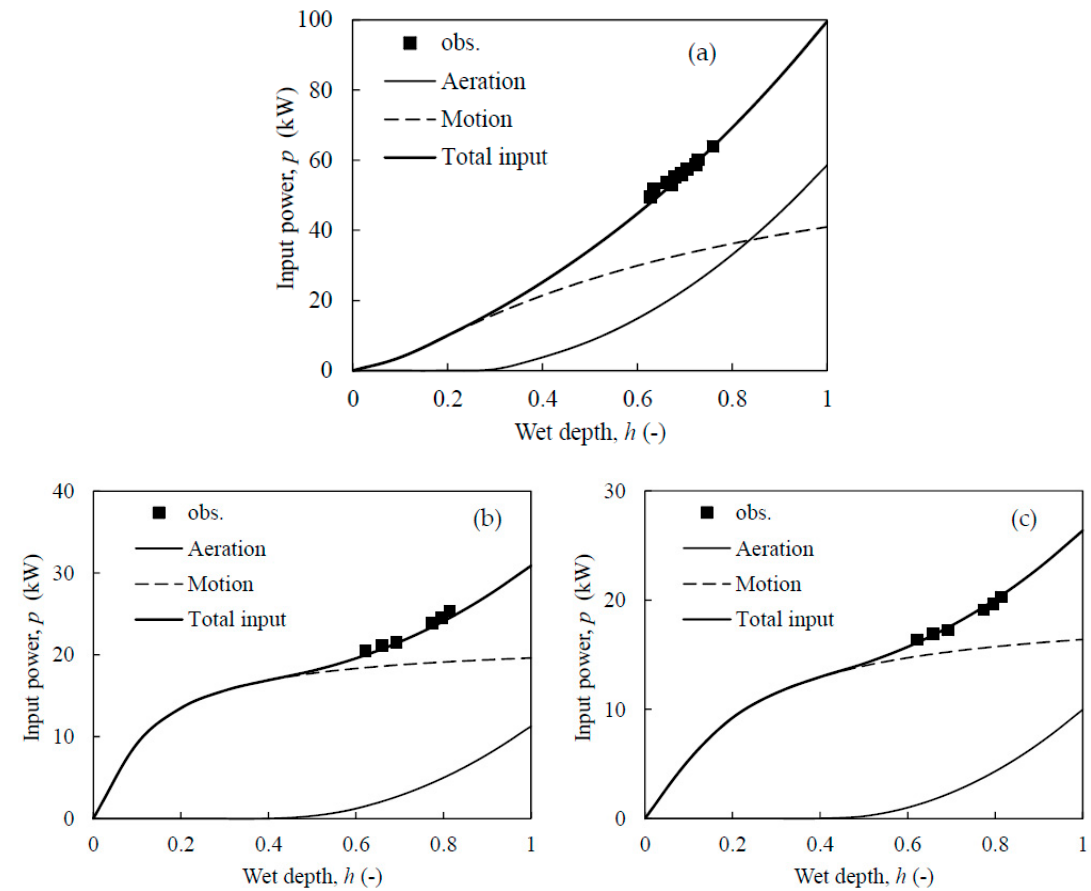
Figure 6. The dependence of input total power p on wet depth h in highest rotating frequency ω at 60 rpm. ( a ) Φ 1800 mm aerators in the OL; ( b ) Φ 1400 mm aerators in the ML; and ( c ) Φ 1400 mm aerators in the IL. Obs is observed data. Solid and dash lines represent aeration energy and motion energy. Bold solid line represents total input power.